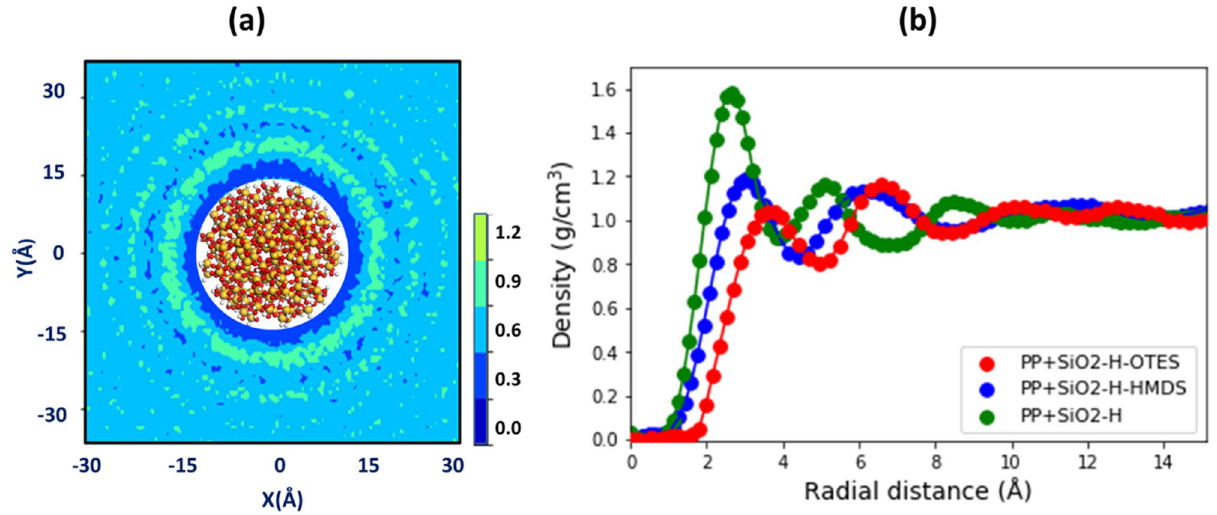
Figure 4. ( a ) The mass density distribution of the PP chains around the SiO 2 nanoparticle functionalized with the HMDS molecules. The density distribution is obtained in a thick square slab with thickness of ∆ = 5 Å. The color bar indicates the mass density range in units [g/cc]. ( b ) The radial mass density profiles of PP polymers calculated as a function of distance from the surface of functionalized SiO 2 nanoparticle in the thermal equilibrium. The density profiles of PP for silica particle passivated with hydrogen (red circles) and in addition functionalized with HMDS (green diamonds) or OTES (blue squares) molecules are